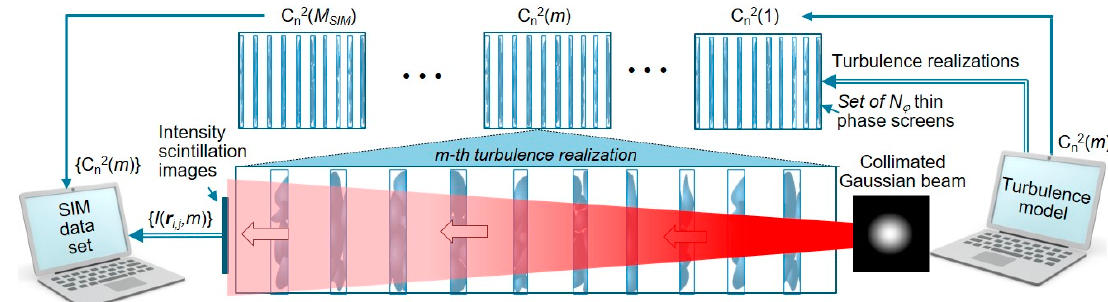
Figure 3. Notional schematic of the numerical simulation setting used for computation of laser beam intensity scintillation images and corresponding refractive index structure parameter C 2 n (simulation (SIM)-datasets) over 7 km under different atmospheric turbulence conditions.